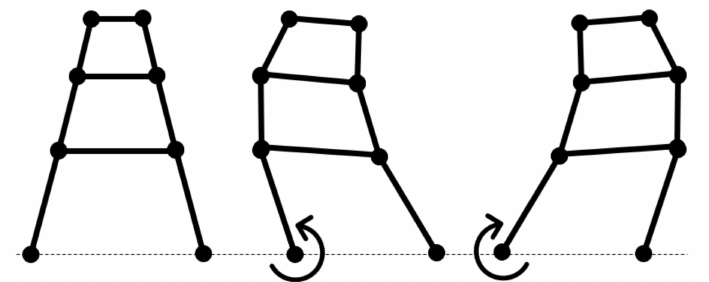
Figure 5. Bar mechanism structure based on the Fin-Ray